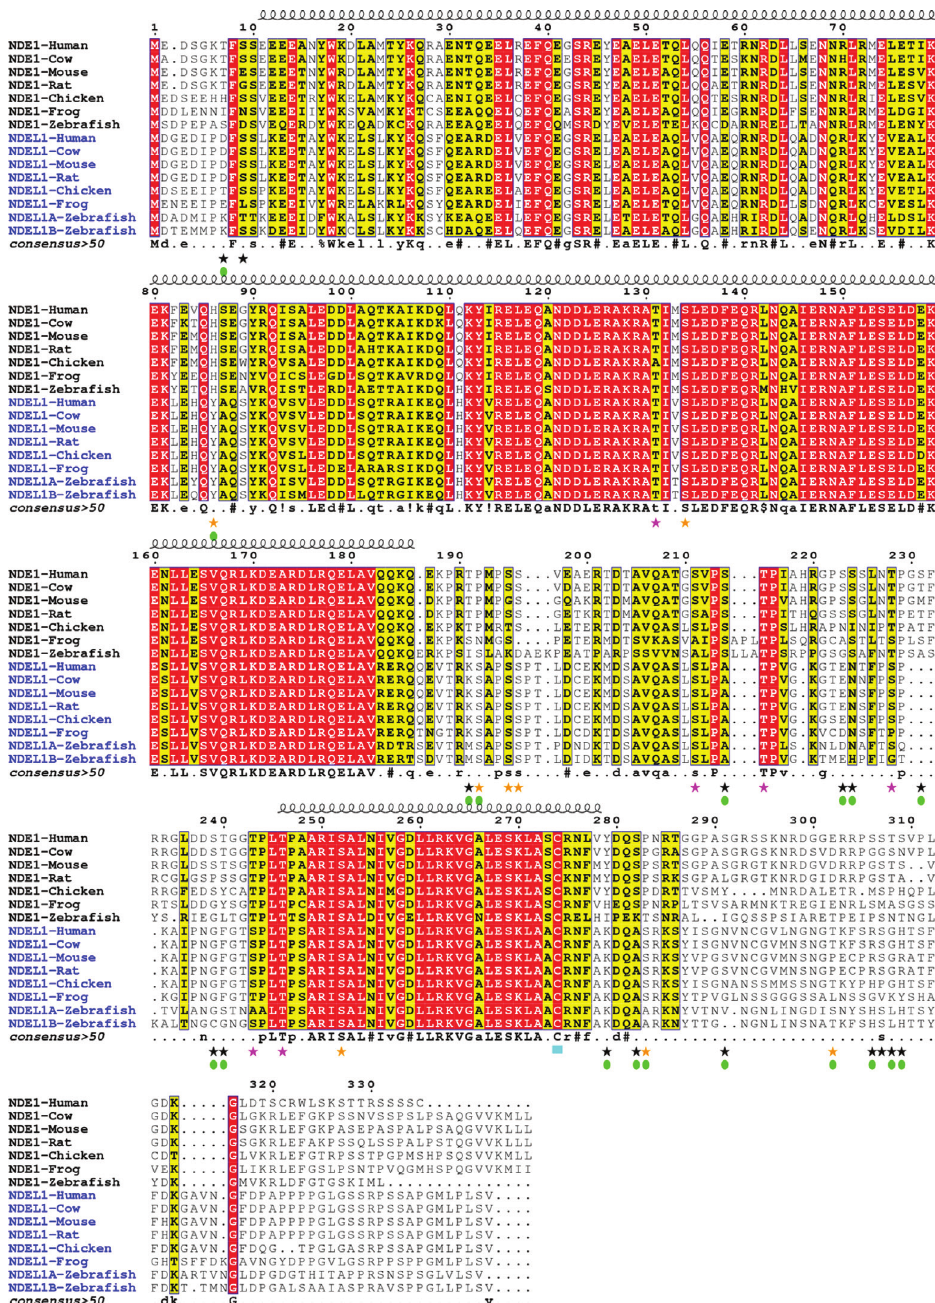
Figure 1 Multiple sequence alignment of NDE1 and NDEL1 orthologs. Orthologs of NDE1 and NDEL1 across vertebrate species were identified using the UCSC Genome Browser (http://genome-euro.ucsc.edu). These were aligned initially using Clustal Omega (108, 109) with further manual editing for optimum alignment. The sequence numbering at the top of each alignment block corresponds to the sequence of human NDE1. Conserved residues are colored with a red background; conserva- tively substituted residues are shown with a yellow background. The location of the N-terminal coiled-coil α -helical domain (residues ∼ 10–185) and the predicted C-terminal α -helix (residues ∼ 247–278) are shown above the alignment. Consensus amino acids are shown at the bottom of the each alignment block (uppercase is strictly conserved; lowercase is consensus level > 0.5; ! is I or V; $ is L or M; % is F or Y; = is N, D, Q or E). Despite 60% sequence identity there are at least 18 specific phosphorylation sites for each human protein – i.e., phosphorylation possible only in one protein. Some of these phosphorylation sites have been derived from high-throughput proteomic screening using mass spectrom- etry (90), while others have been experimentally verified in the cell. See the main text and Table 2 for more information. Those sites known to be specific to either NDE1 or NDEL1 are highlighted with a green filled oval under the corresponding star; black star = phosphorylation site in NDE1; orange star = phosphorylation site in NDEL1; pink star = phosphorylation site in both NDE1 and NDEL1; cyan block = palmitoylation site in both proteins. The figure was generated with ESPript v2.2